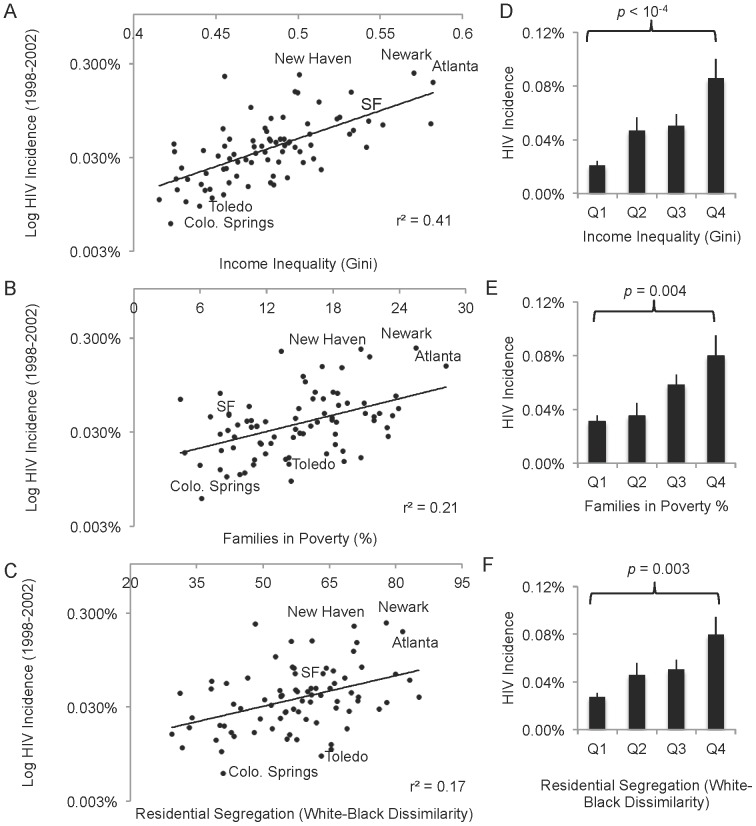
Income inequality, segregation and poverty positively and synergistically correlate with 1998-2002 HIV incidence across 80 U.S. cities.
A–C. The total reported HIV incidence in 80 large U.S. cities as a function of: (A) income inequality (represented as the Gini coefficient, where higher values correspond to greater inequality); (B) poverty, and (C) black-white dissimilarity index, a measure of black-white segregation where 0 is completely integrated and 100 completely segregated; and. Cities high in all three social determinants tend to be significantly higher in HIV incidence and vice versa (SF = San Francisco). D–F. Cities were sorted by (D) income inequality, (E) poverty or (F) black-white segregation, and the HIV incidence averaged over quartiles, where Q1 represents the average HIV incidence for the 20 cities with the highest income inequality and Q4 the average HIV incidence in the 20 cities with the lowest income inequality. T-test comparison of the HIV values in first and fourth quarters illustrates these populations are statistically distinct (see Table 1). Bars = SEM.